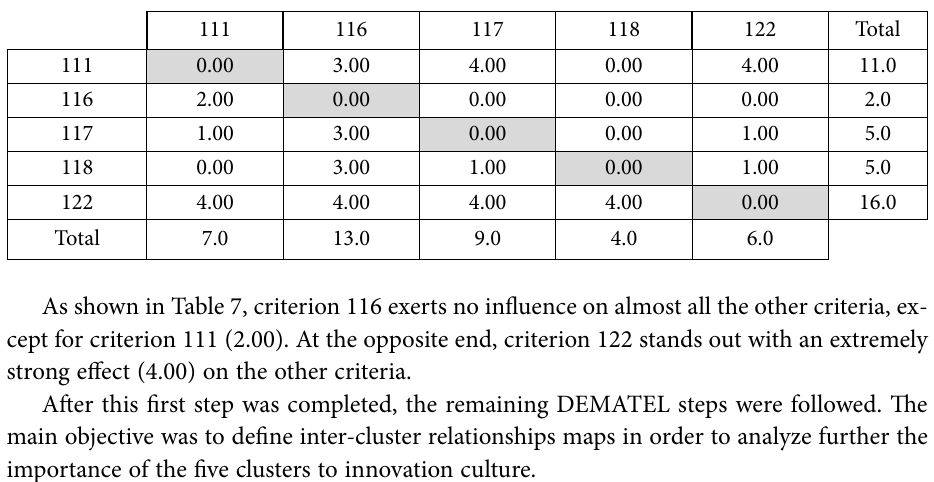
Table 7. Direct influence matrix for C5 Training